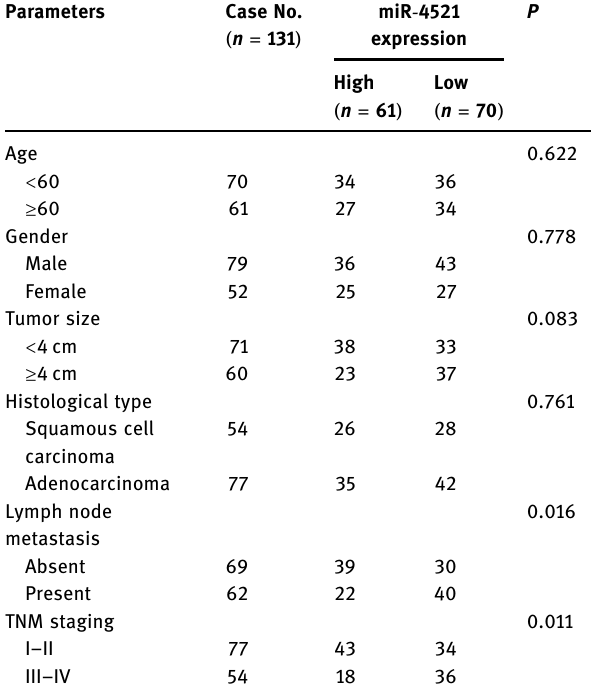
Table 1: Correlation between miR - 4521 expression levels and clinical features in NSCLC